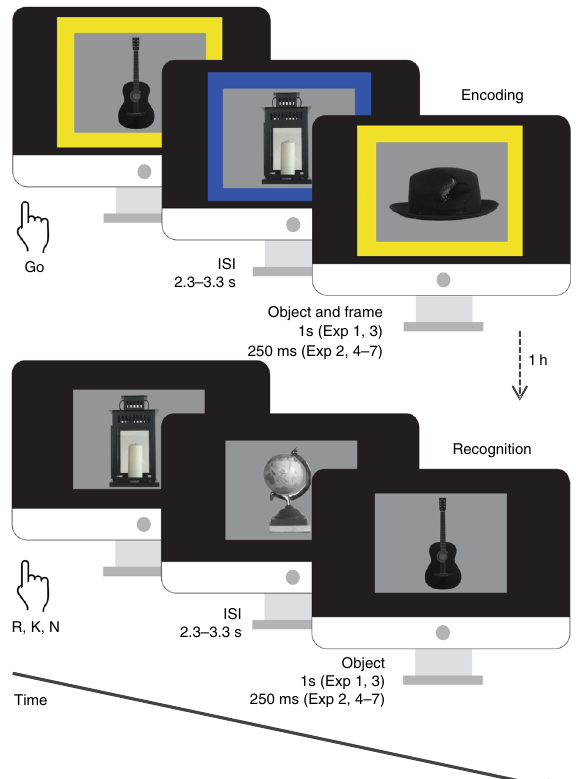
Fig. 1 Behavioral task. Incidental memory encoding in the context of a Go/ NoGo task. At encoding, grayscale objects were presented with a color fame indicating requirement of a button press for the Go condition or withholding the response for NoGo. A surprise recognition test was conducted one hour later (or one day later Exp 7), during which participants were presented with objects from the encoding task intermixed with an equal number of lure items (presented without a frame) and indicated whether they remembered (R), were familiar with (K) or did not